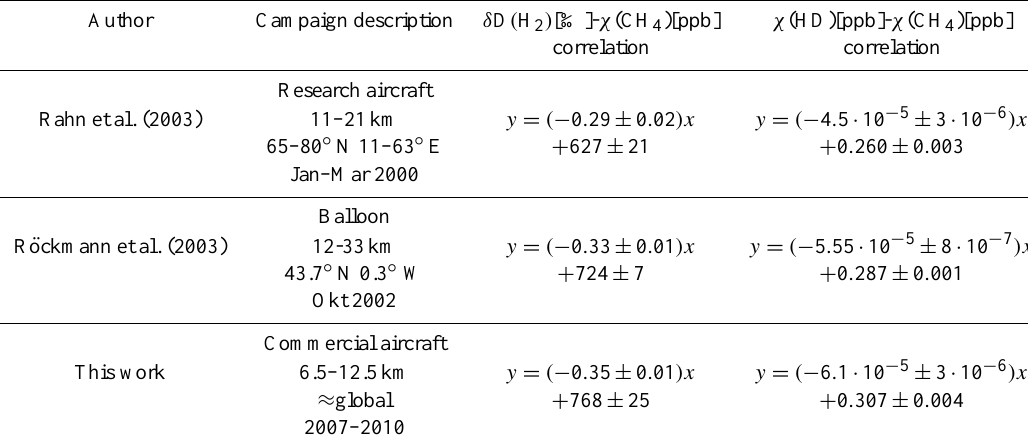
Fig. 5. δ D plotted against χ (N 2 O) (a) and χ (CH 4 ) (b). Solid lines are W-Y fits (Cantrell, 2008). Different colors and markers indicate different sampling latitude bands. Open symbols denote outlying datapoints that were left out of the fitting procedure. Table 2. Campaign description and correlations between δ D or χ( HD ) and methane from different publications. Methane mixing ratio data ( χ( CH 4 ) ) from Rahn et al. (2003) and R¨ockmann et al. (2003) were multiplied by a factor of 1.0124 to convert them to the NOAA2004 scale. All fits were made with the Williamson-York algorithm described by Cantrell (2008). No error estimates for the individual measurements were taken into account for the literature